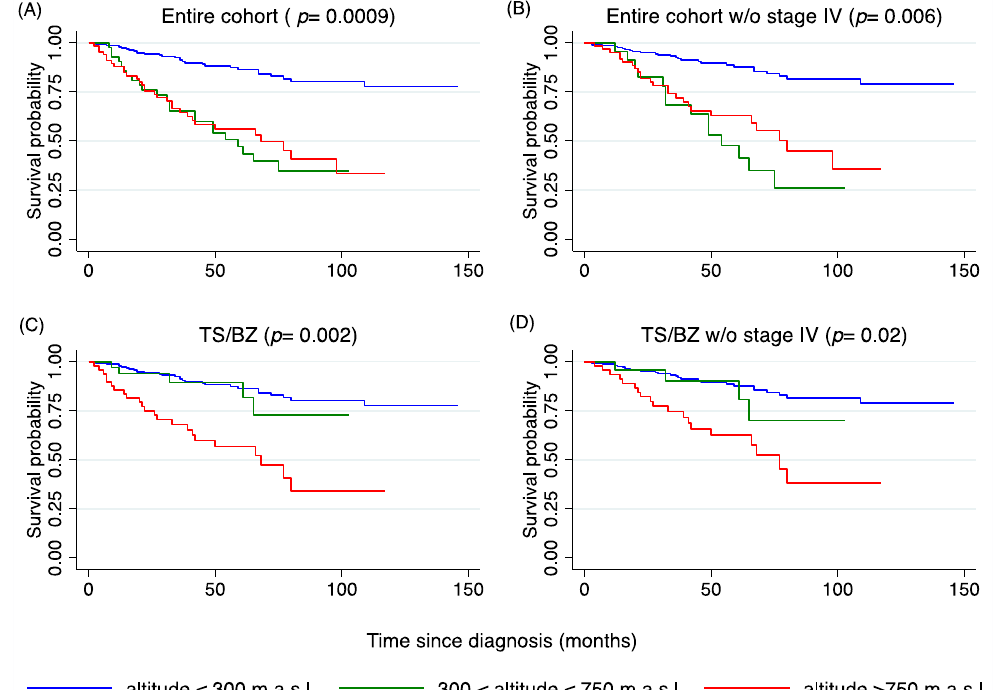
Figure 5. Kaplan Meier survival curves for melanoma-specific survival adjusted for age at diagnosis (MSS) for altitude of residence ranges (under 300 m, between 300 and 750 m, and above 750 m); ( A ) entire cohort, p = 0.0009; ( B ) entire cohort without stage IV CM, p = 0.006; ( C ) in cases from TS/BZ, p = 0.002 and ( D ) in cases from TS/BZ without stage IV CM, p = 0.02. The graphs of the survivor function were adjusted to the mean age of patients (57.6 years). MSS: melanoma-specific survival ( p values on the graph refer to the log-rank test).